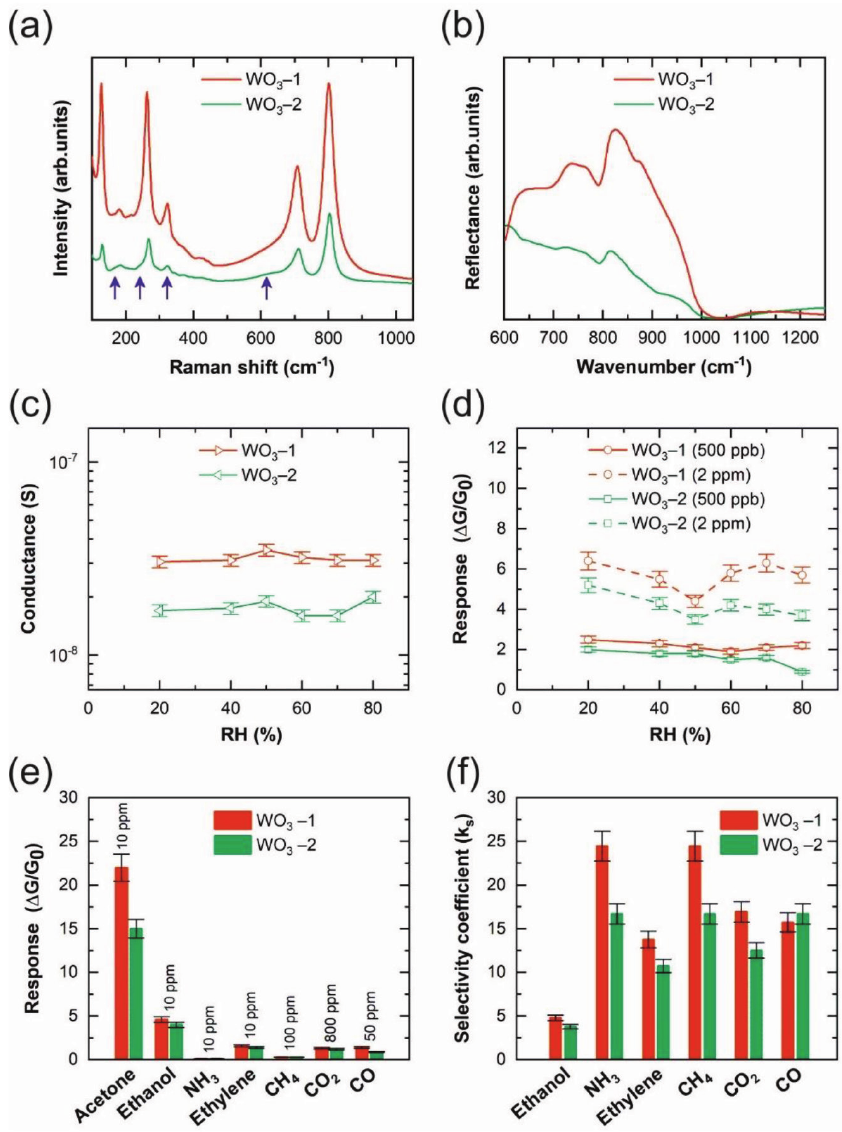
‒1 † and WO ‒2 ‼ structures. The blue arrows in the spectrum of WO ‒2 show the orthorhombic β-WO Figure 6: (a) Raman spectra of WO 3 3 3 phase. (b) FTIR reflectance spectra of WO ‒1 and WO ‒2 in the spectral region between 600 and 1200 cm -1 . (c) Conductance dependence 3 3 of WO ‒1 and WO ‒2 from the concentration of RH at 400°C. (d) Response values of WO ‒1 and WO ‒2 to 500 ppb and 2 ppm of acetone 3 3 3 3 at different concentrations of RH. (e) Response of WO ‒1 and WO ‒2 towards acetone, ethanol, ammonia (NH ), ethylene, methane (CH 3 3 3 carbon dioxide (CO ), and carbon monoxide (CO) at 400°C. (f) Selectivity of WO ‒1 and WO ‒2 against interfering gases at 400°C ( ks was 2 3 3 calculated using the response values of sensors towards 10 ppm of acetone with respect to their response values towards ethanol (10